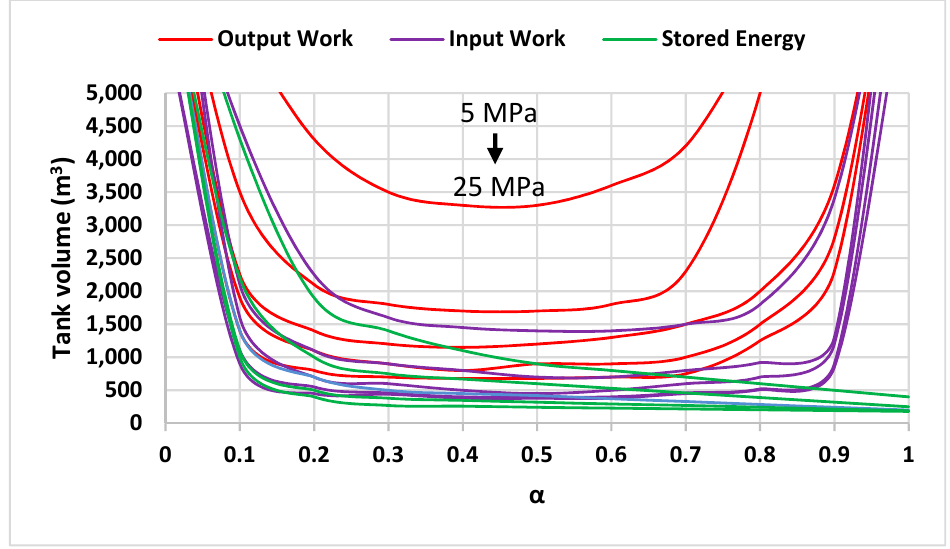
Figure 17. Reservoir volume changes concerning α for a specific input work, output work, and stored energy (5000 MJ) for different pressures (5 to 25 MPa with steps of 5 MPa)